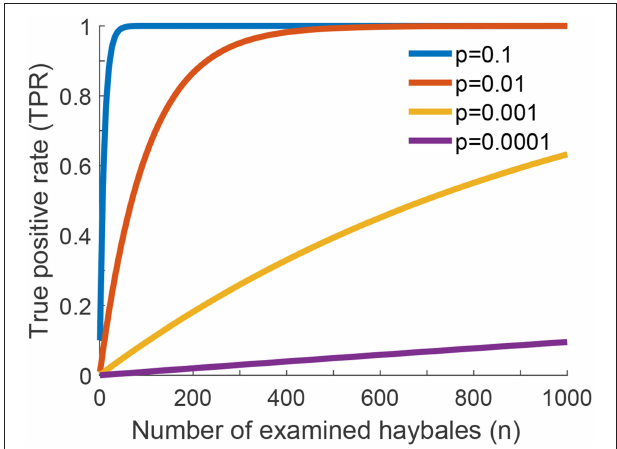
FIGURE 2 | True positive rate ( TPR ) for one-phase search strategy assuming no errors in the classification of individual haybales. The global true positive rate ( TPR ) of the search problem as a function of the number of examined haybales for different values of p is shown (see Equation 2 of Supplementary Information ). p is the fraction of relevant instances present in the